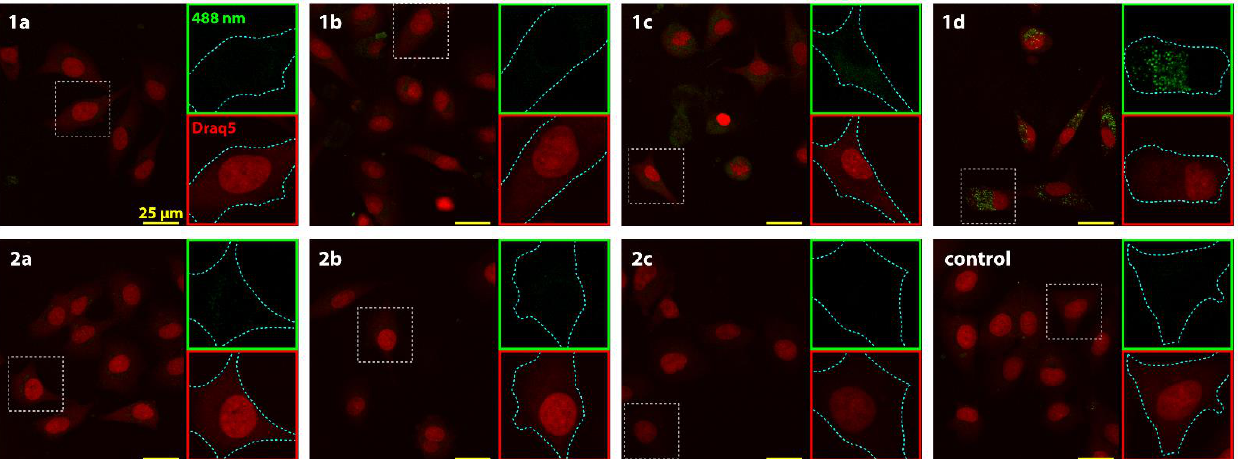
experiments; statistical significance (*): p < 0.05 for each experimental group compared to the untreated control.